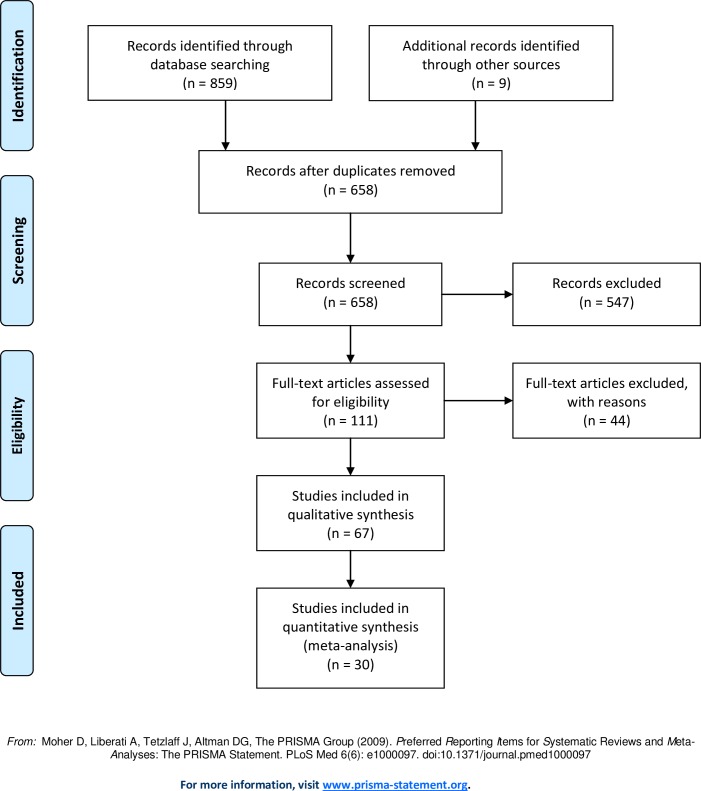
Flowdiagram of search and selection strategy in a systematic review and meta-analysis of sperm DNA fragmentation tests and pregnancy rates after MAR.Legend: not applicable.